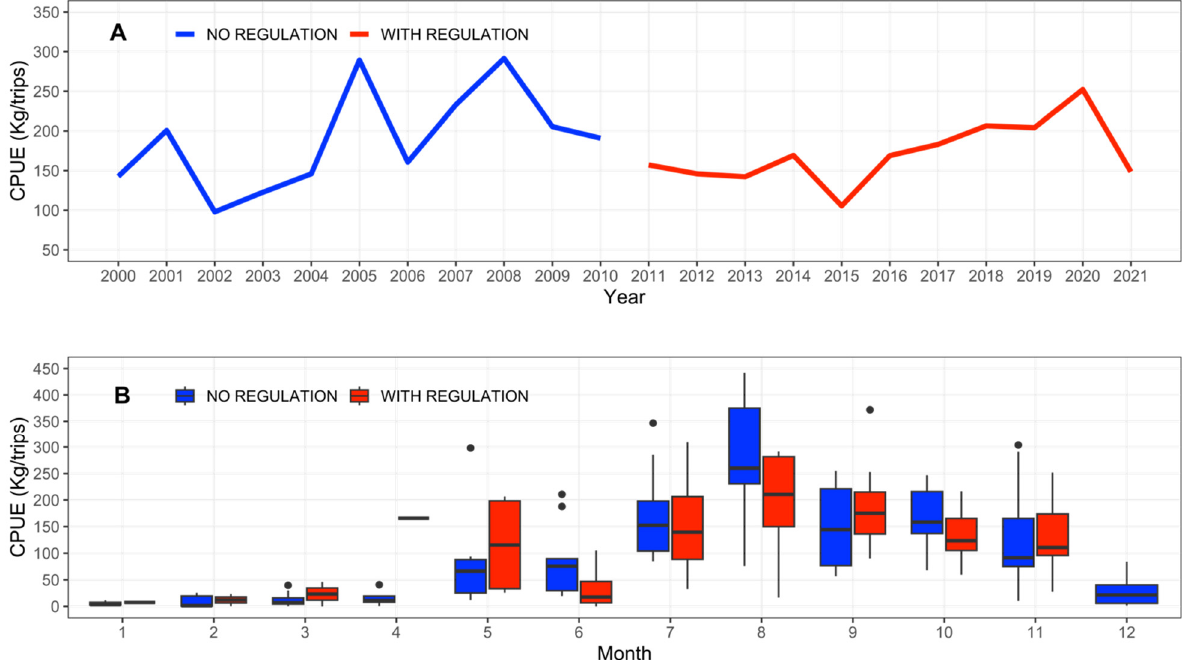
Figure 6. ( A ) CPUE distribution (2000–2021), for purse seine fleet that only target S. dumerili , as a function of the Regulation, (blue—before 2011; red—after 2011). ( B ) Monthly CPUE distribution, as a function of the Regulation (blue—before 2011; red—after 2011).